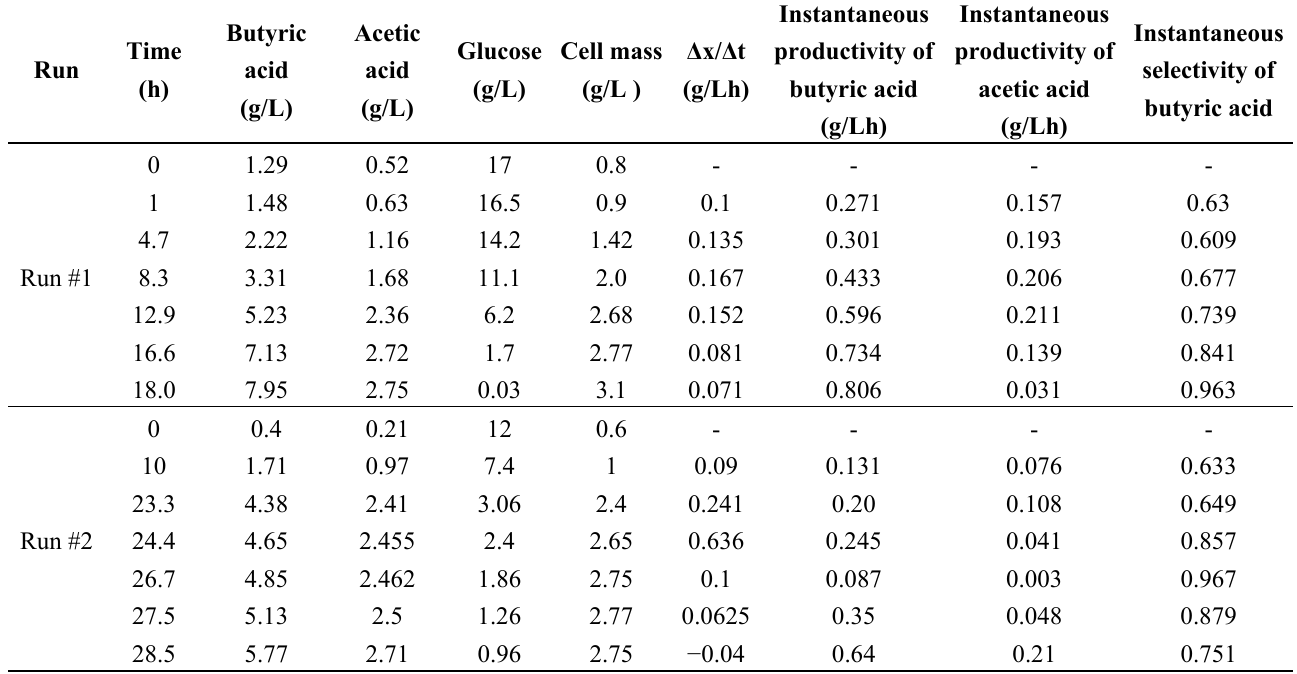
Table 2. C. tyrobutyricum batch fermentation kinetics at pH 6.8.